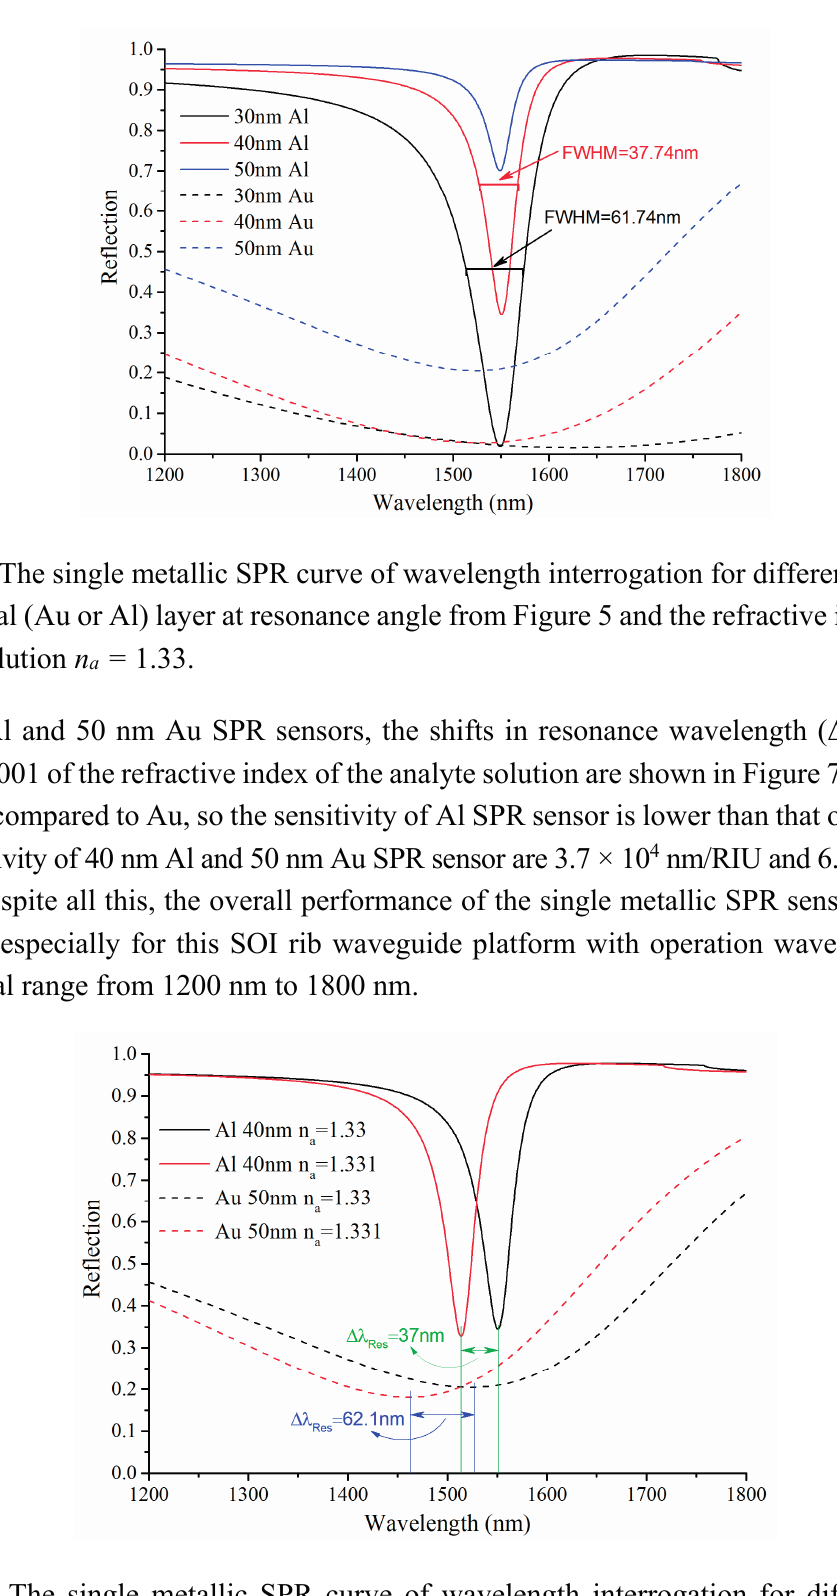
Figure 7. The single metallic SPR curve of wavelength interrogation for different SPR active metal (Au or Al) and different refractive index of the analyte